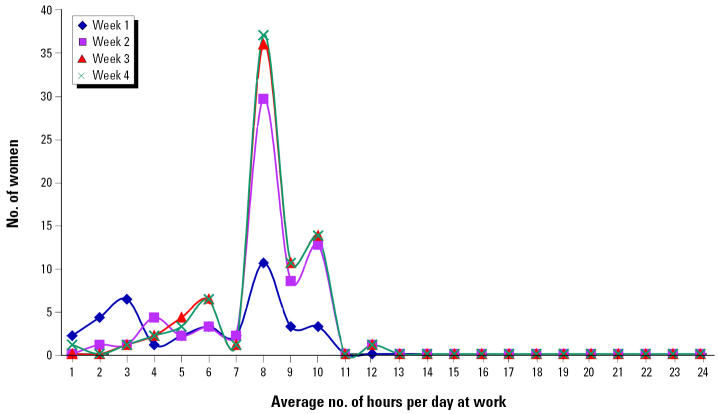
Average hours at work per day for women working within 2 miles of the WTC site.